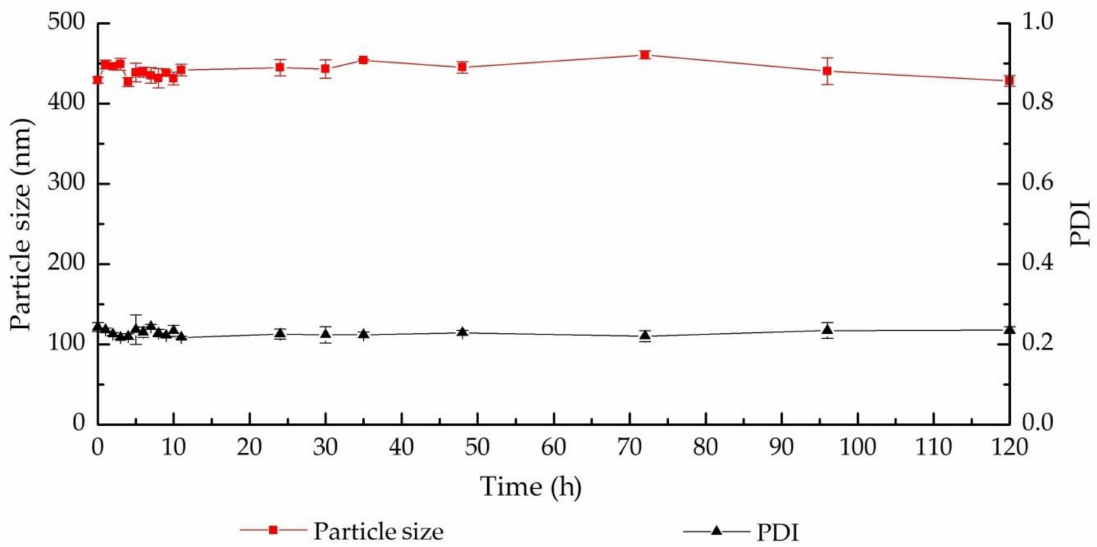
Figure 8. Characterization of the nanohydrogel stability in phosphate buffered saline (PBS, 10 mM, pH 7.4) at 37 ◦ C by particle size and PDI